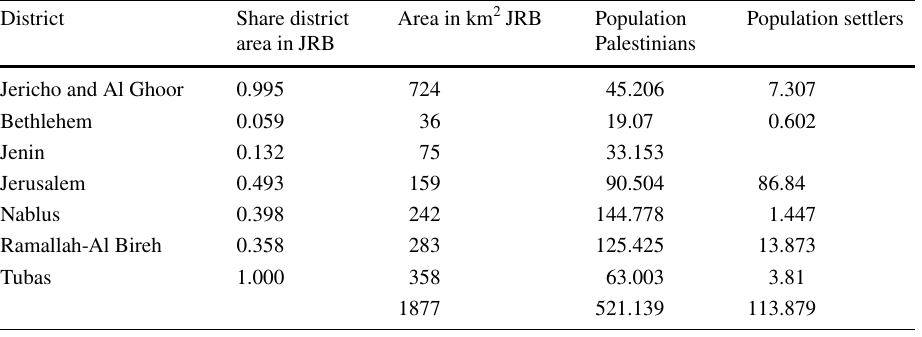
Table 1 Districts sharing the JRB catchment: area and population distribution